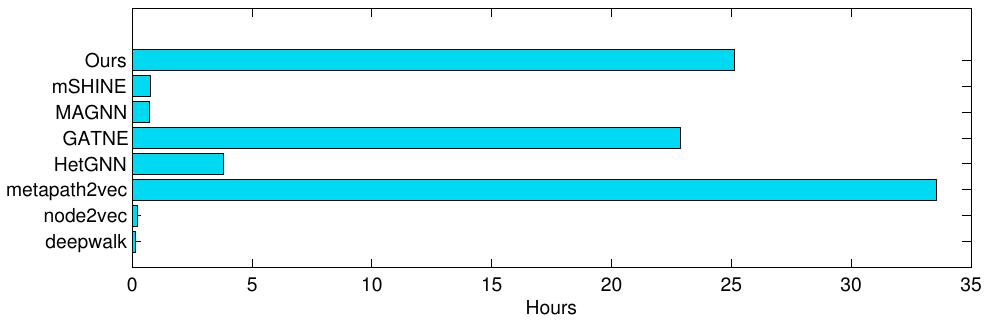
Figure 7. Computational times of each method over the YouTube